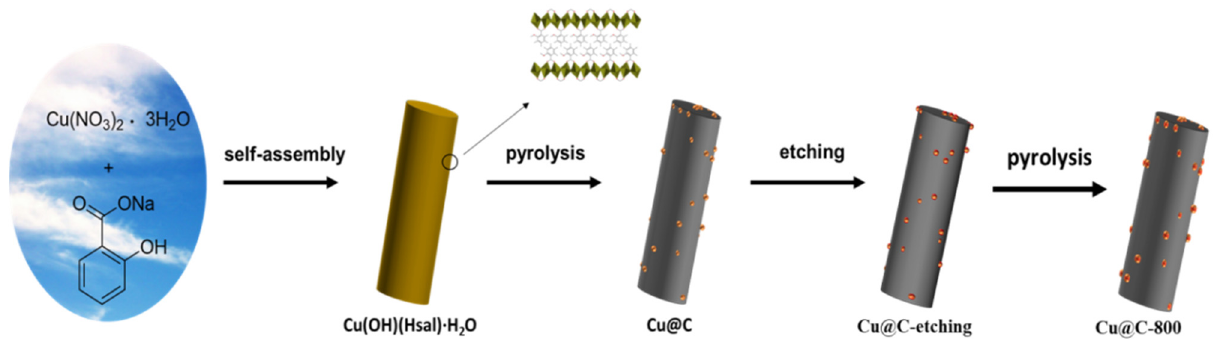
Figure 1. Cu@C-800 synthesis strategy.